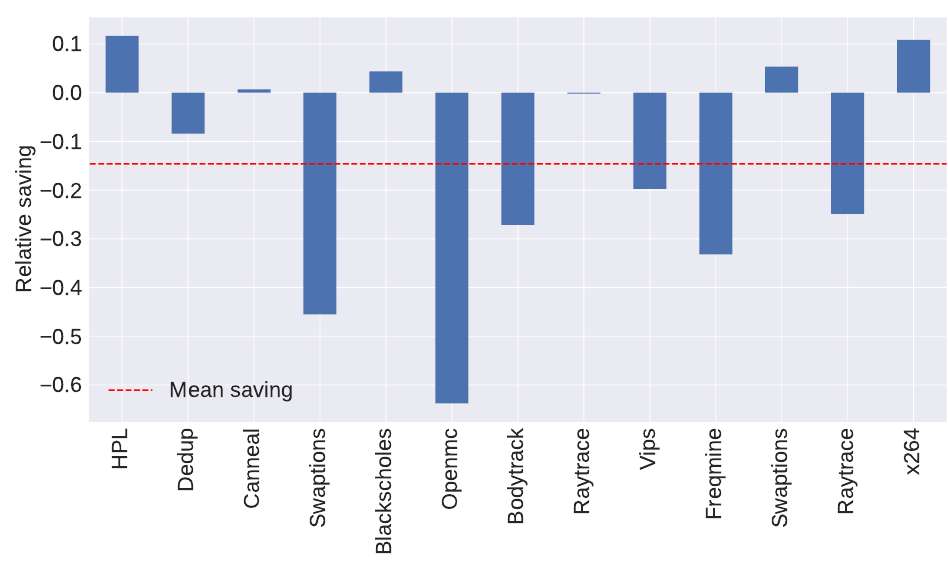
Figure 17. Energy savings comparisons between the proposed model and the Best case.